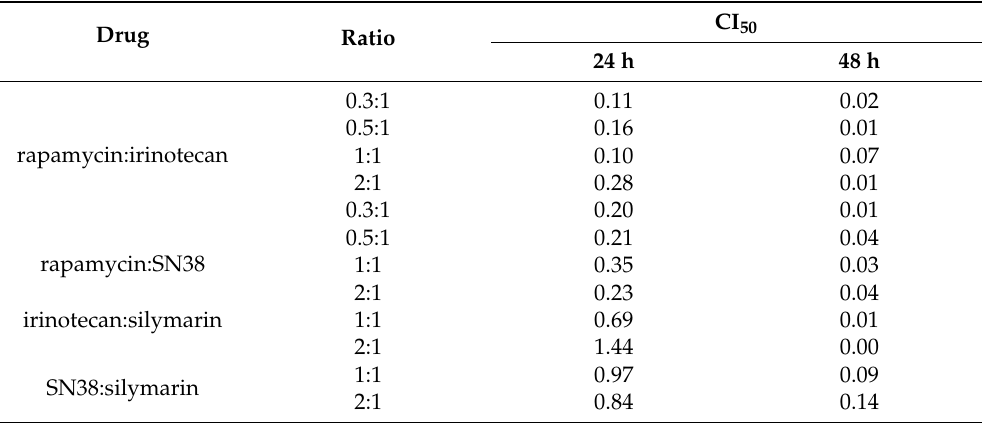
Table 6. Combination index (CI 50 ) for different ratios of irinotecan, SN38, rapamycin, and silymarin at 24 and 48